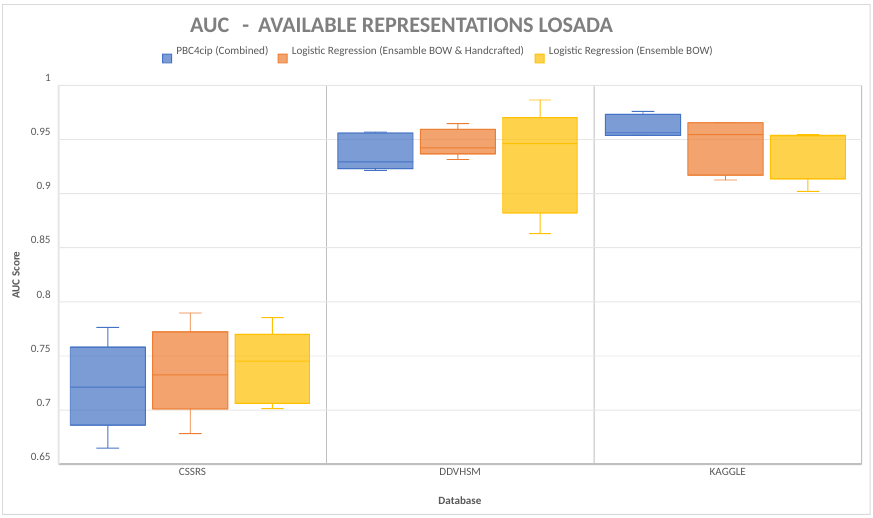
Figure 5. A comparison plot of the AUC for the best proposed representation using PBC4cip, and the available representations from Losada’s databases.